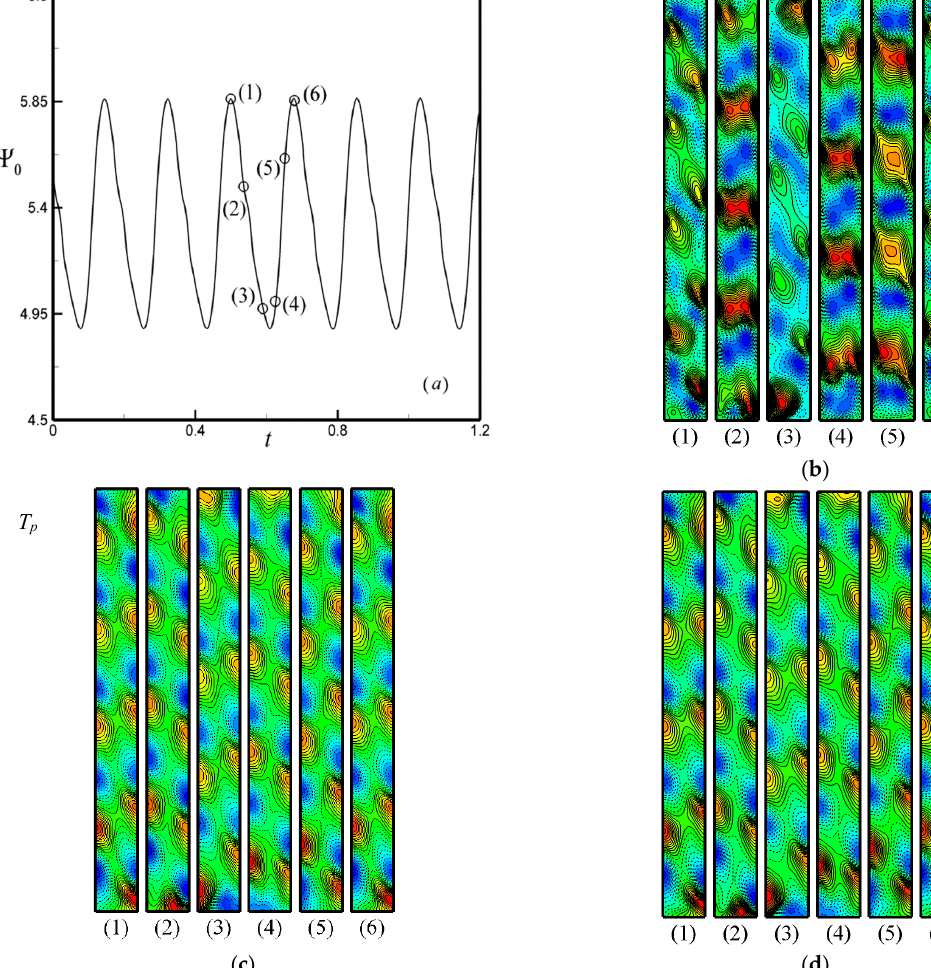
Fluids 2021 , 6 , x FOR PEER REVIEW